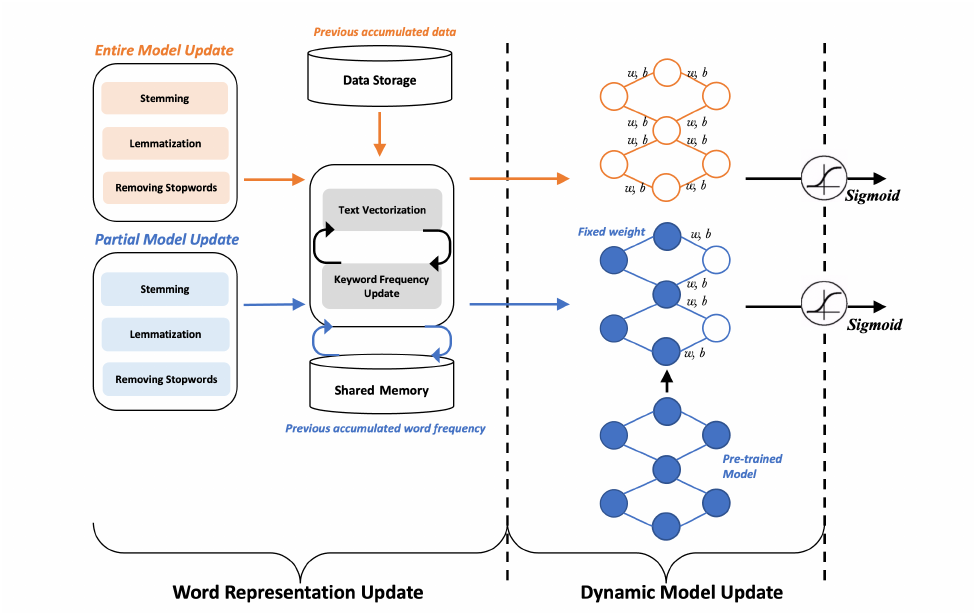
Figure 3. Continual machine learning pipeline for classification supporting dynamic model